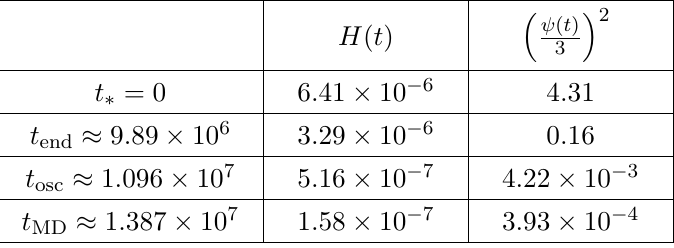
Table 1. The values for H and of both the oscillatory and matter dominated regimes respectively. We have set M p = 1.